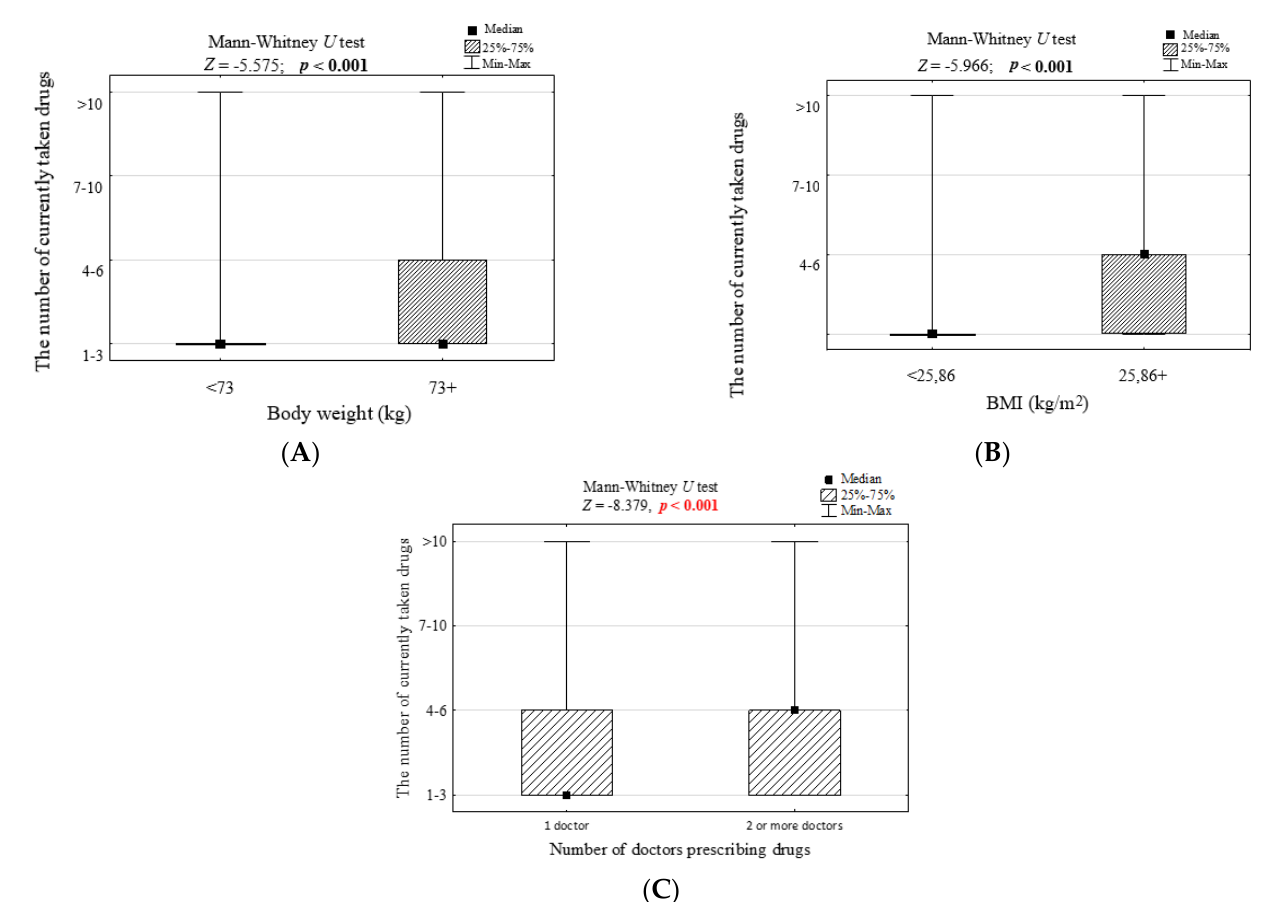
Figure 2. The number of drugs currently taken in groups of people differing in ( A ) body weight, ( B ) body mass index, the number of doctors who prescribed medicines ( C ) and the results of signifi- cance tests.